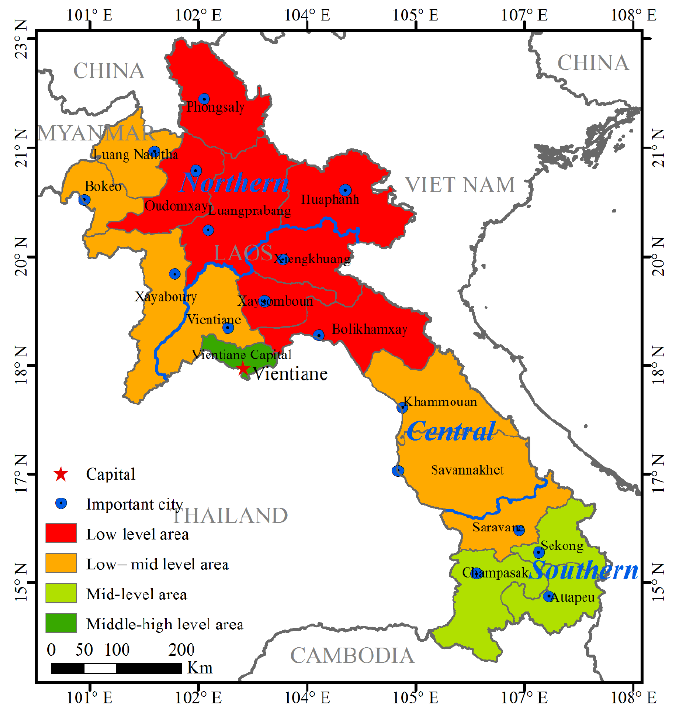
Figure 8. Spatial pattern of classification of socio ‐ economic development in Laos.